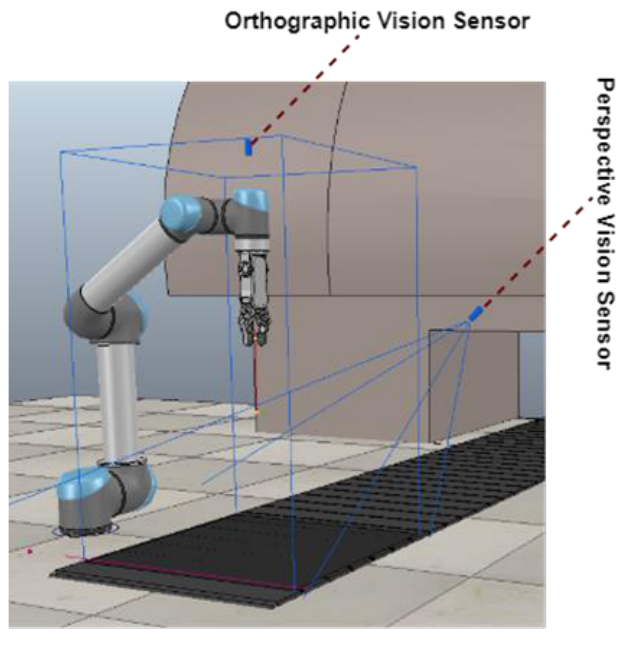
Figure 2. Location and field views of vision sensors in the simulated setup.